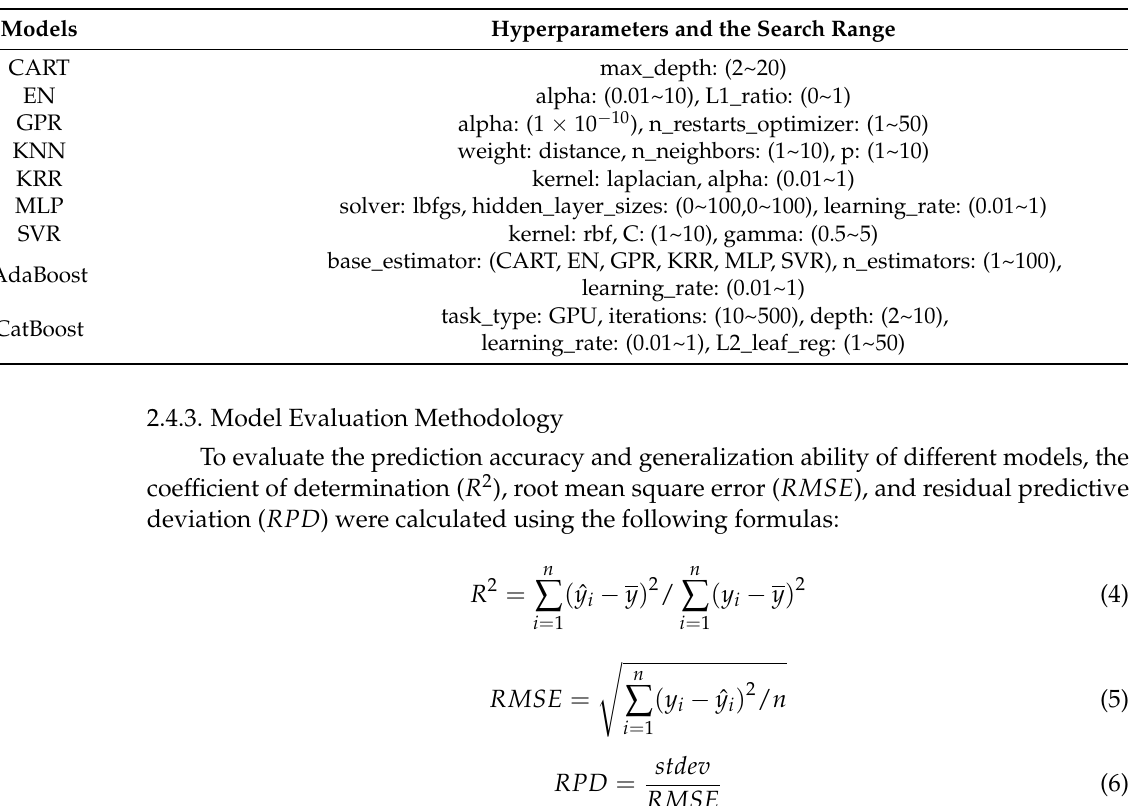
Table 3. Hyperparameter tuning